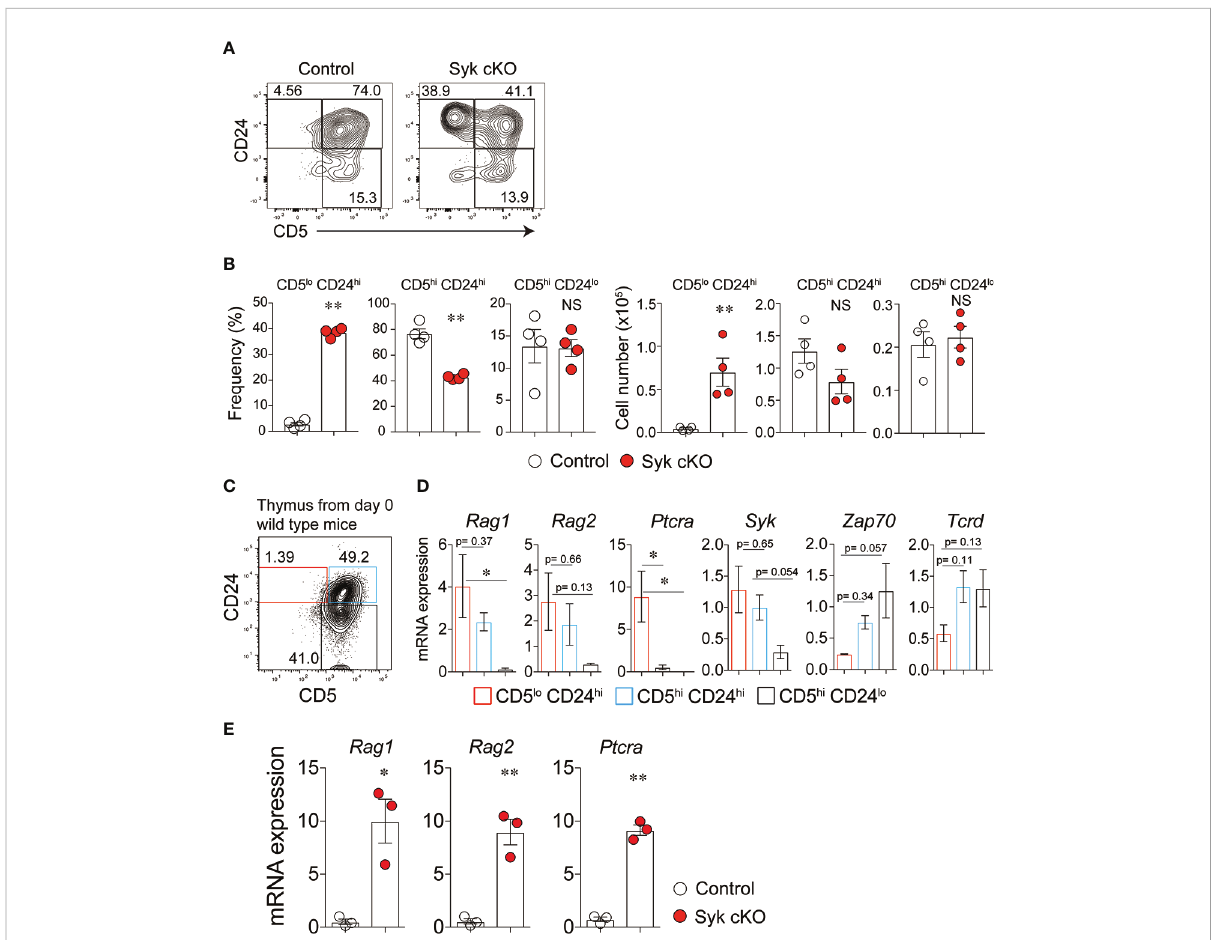
FIGURE 2 Impaired gd -selection in Syk-cKO mice. (A, B) Flow cytometric pro fi les of CD5 and CD24 expression in total gd T cells from thymuses of control or Syk-cKO mice (A) and the number and frequency of the indicated gd T cell subset are shown (B) . (C) Flow cytometric pro fi les of CD5 and CD24 expression in thymic gd T cells from 0-day-old wild-type mice. (D) mRNA expression of the Rag1 , Rag2 , Ptcra (pT a ), Syk , Zap70 and Tcrd in gd T cell subsets shown in (C) . Gene expression was normalized to Gapdh , and those in total thymic gd T cells were arbitrarily set to 1. (E) mRNA expression of Rag1 , Rag2 and Ptcra in thymic gd T cells from the indicated mice (n = 3). Gene expression was normalized to Gapdh . All data represent the mean ± SEM. In (A) and (B) , data are obtained from two independent experiments. *P < 0.05 and **P < 0.01, by 1-way ANOVA (D) or unpaired t-test (B, E) . NS, not signi fi